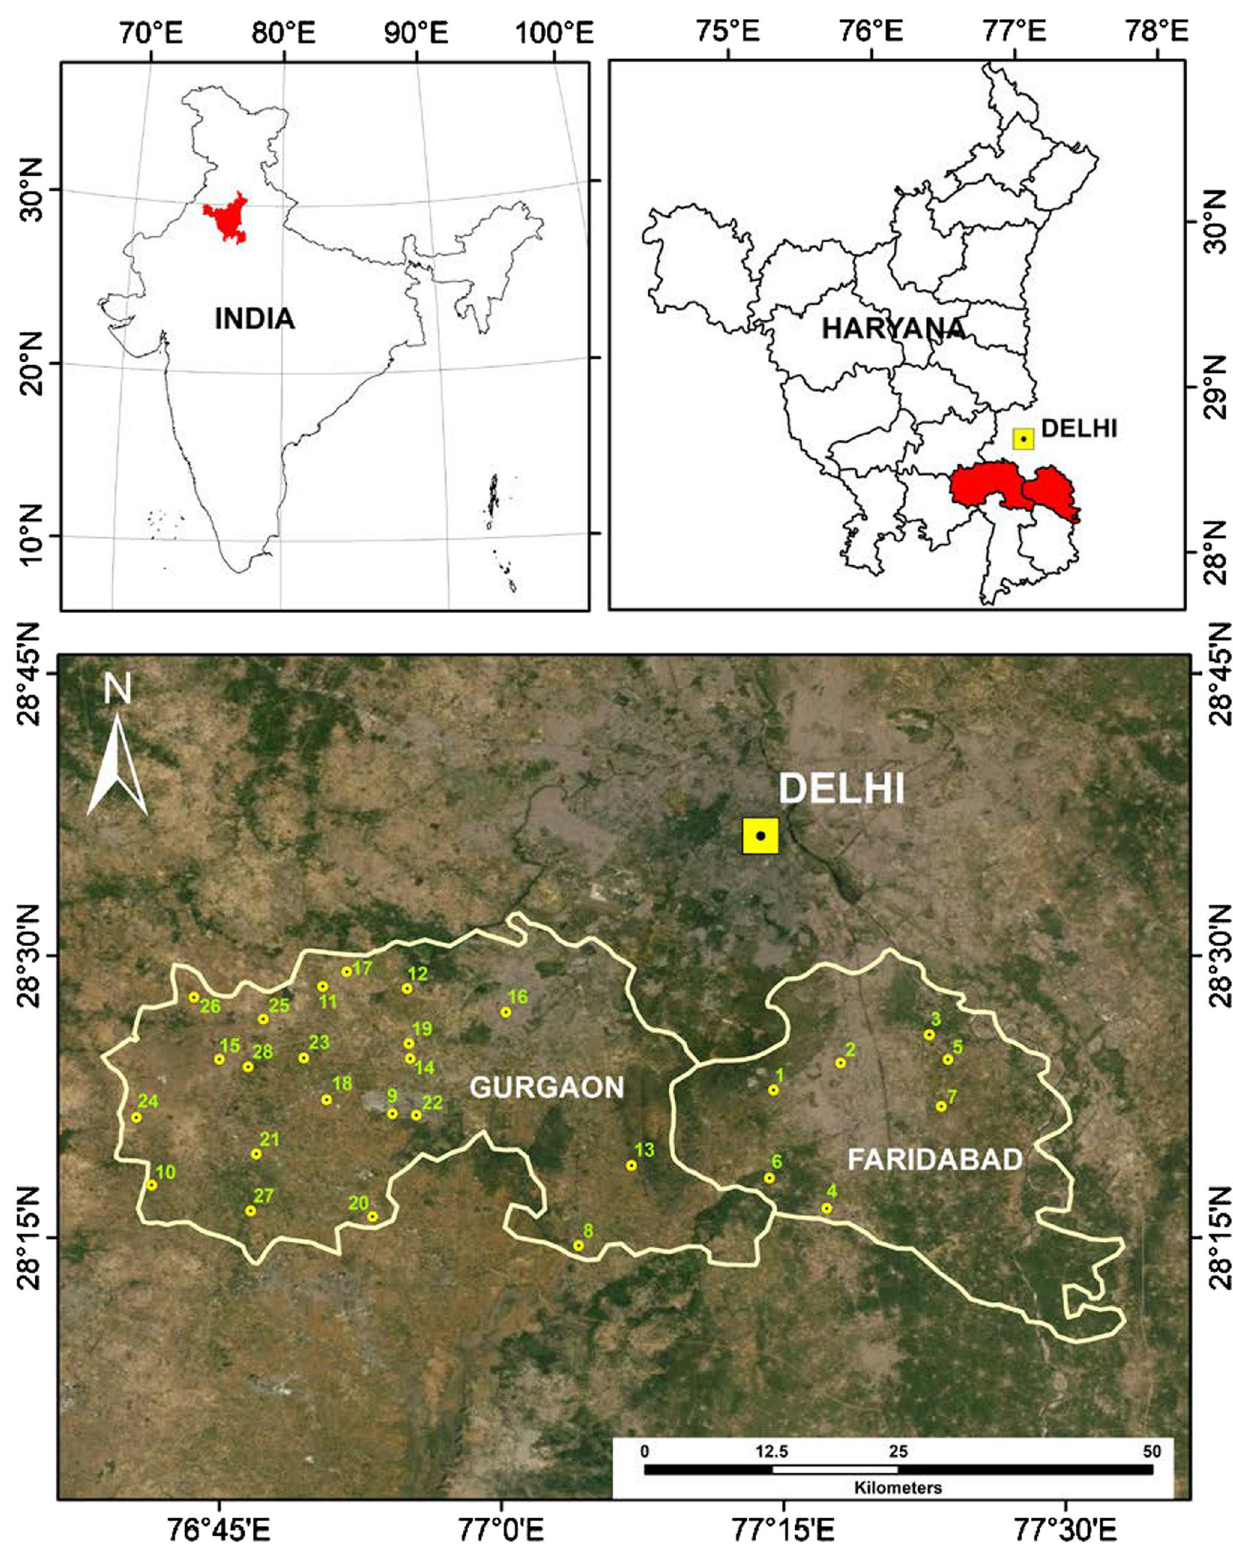
Fig. 1 Location of the study area (Gurgaon and Faridabad districts, Haryana,